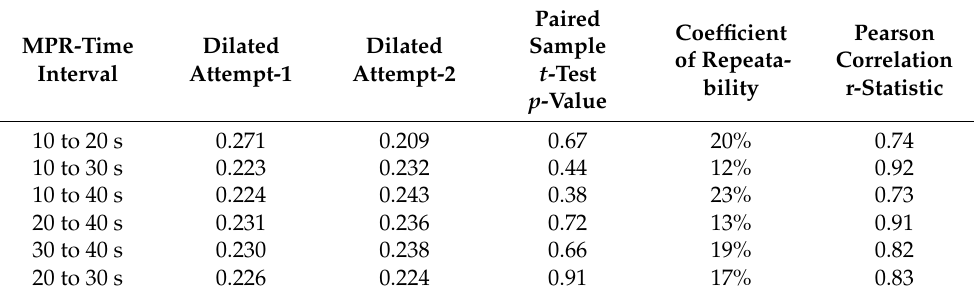
Table 7. Lutein optical density measurements obtained through pharmacologically dilated pupillary conditions.